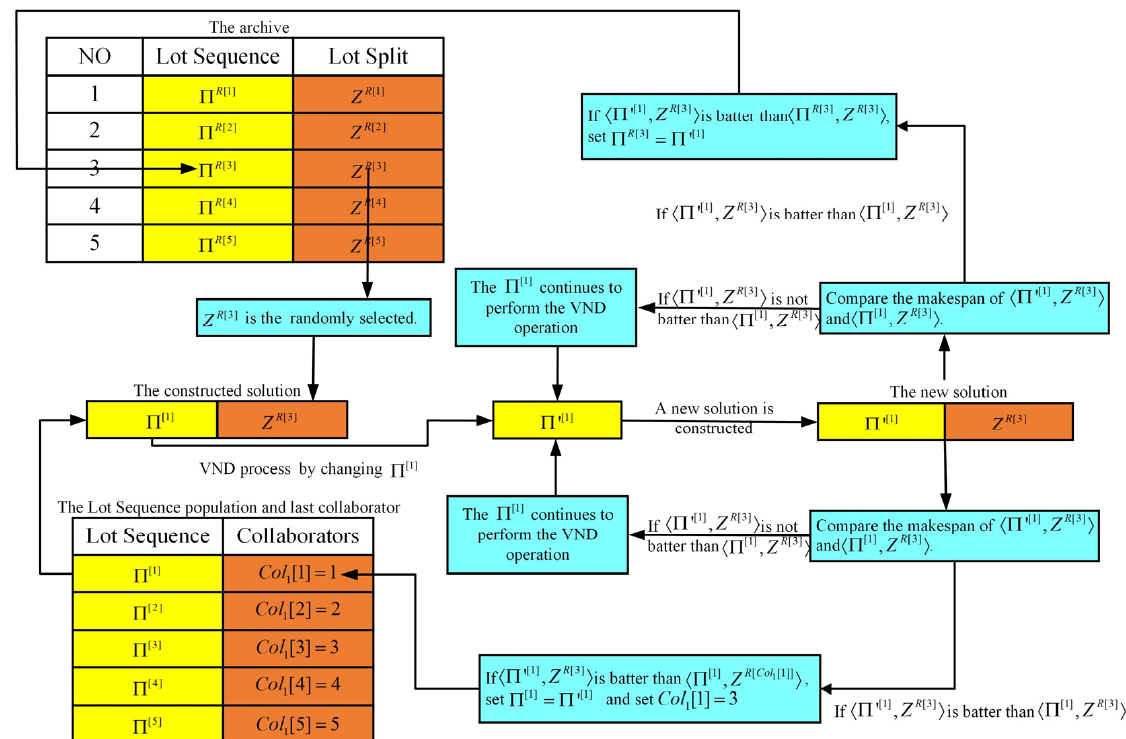
Figure 3. Evolution process of the lot sequence population.